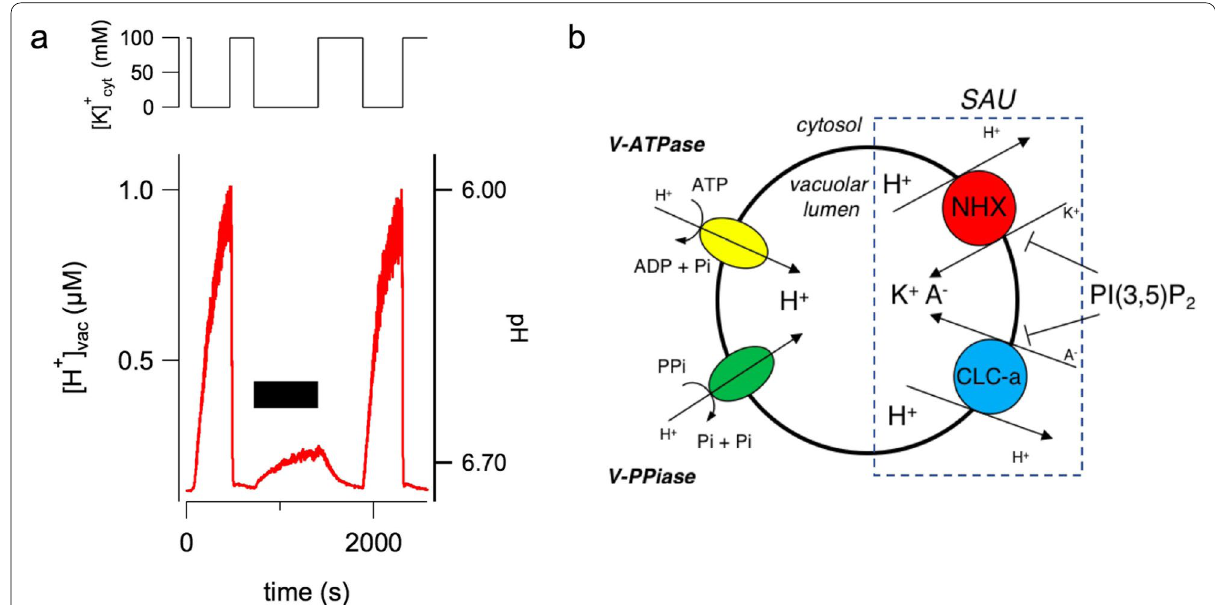
Fig. 7 The phosphoinositide PI(3,5)P 2 inhibits NHX activity. a PI(3,5)P 2 added at a concentration of 200 nM in the bath solution lacking potassium, which is substituted by the large, membrane- impermeable cation BTP + (no K + BTP + ), induces a strong and reversible inhibition of the vacuolar + acidification mediated by NHX activity. b Scheme of the tonoplast key players responsible of vacuolar salt uptake. A Salt Accumulation Unit (SAU) is formed by NHXs together with CLC-a. V-ATPase, vacuolar H + -ATPase; V-PPiase, vacuolar H + - pyrophosphatase. A − , H + and K + indicates respectively anions, protons and potassium ions; the dimension of the letters for the ions is proportional to their concentration. Modification of Fig. 6,